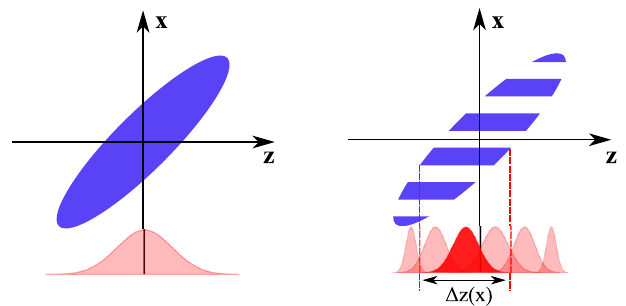
FIG. 2. Conceptual drawing to show shaping quality degrada- tion due to nonzero